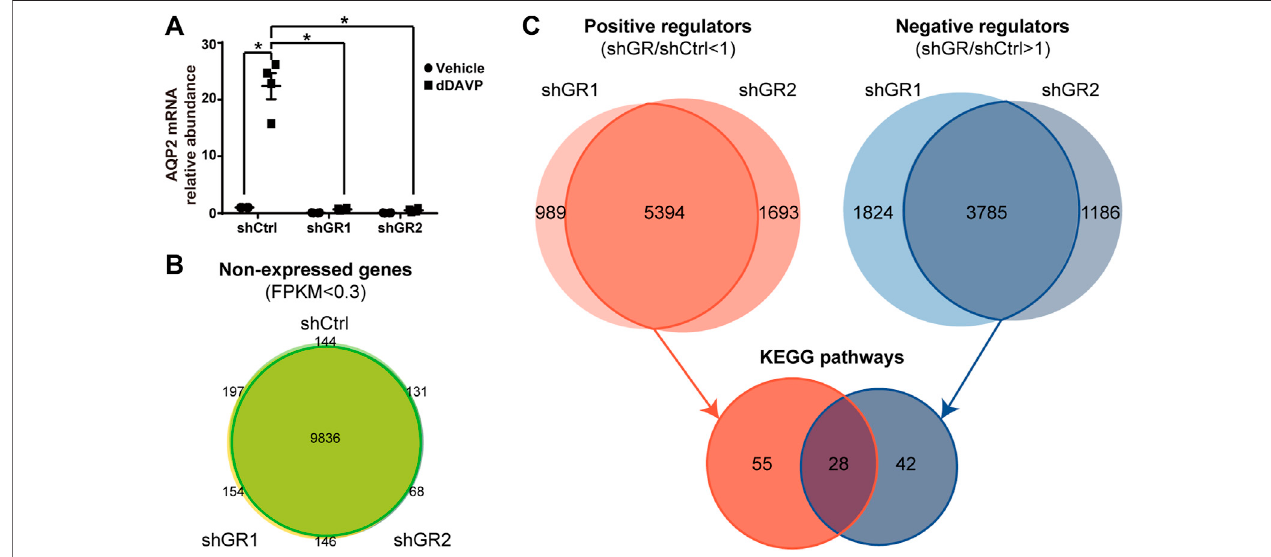
FIGURE 1 | Glucocorticoid receptor knockdown altered the transcriptomic landscape of the mpkCCD cells under the vehicleconditions. (A) Quantitative RT-PCR measurementsoftheAQP2mRNAlevelincontrol(shCtrl)andglucocorticoidreceptorknockdown(shGR1andshGR2)cellsinresponsetovehiclevs.1nMvasopressin analog dDAVP for 24 h. (B) Venn diagram summary of the non-expressed genes in the shCtrl, shGR1, and shGR2 cells based on RNA-seq. Non-expressed genes are those with FPKM (Fragments Per Kilobase of transcript per Million) value < 0.3 under all experimental conditions. (C) Venn diagram summary of positive and negative regulators for the Aqp2 gene expression. Positive regulators are downregulated genes with lower FPKM in the shGR vs. shCtrl cells (shGR < shCtrl). Negative regulators are upregulated genes with higher FPKM in the shGR vs. shCtrl cells (shGR > shCtrl). Positive regulators (red line enclosed) and negative regulators (blue line enclosed) common to shGR1 and shGR2 cells were subjected to KEGG pathway analysis using the DAVID